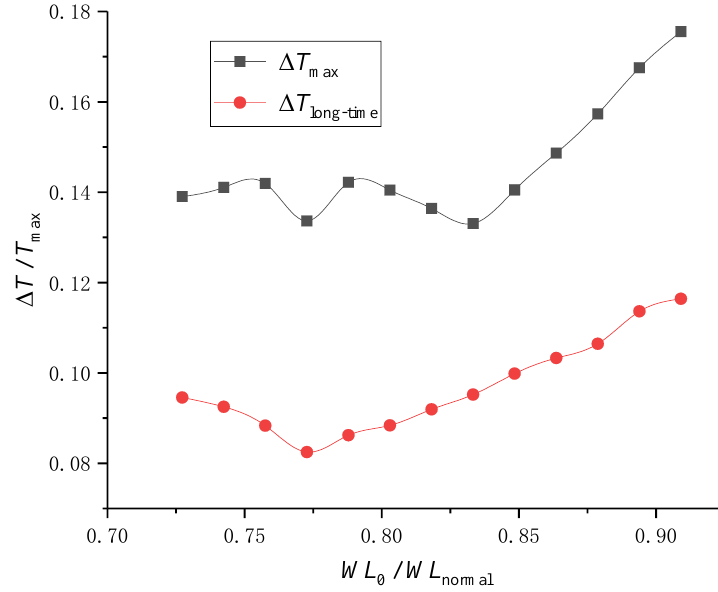
Figure 9. The temperature difference in different initial water levels ( WL ).